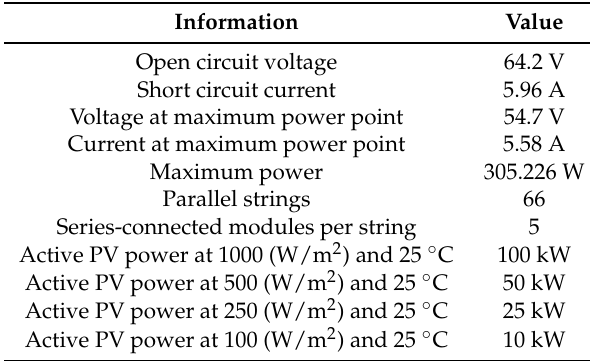
Table 2. Specifications of SunPower SPR-305E-WHT-D (SunPower, San Jose, CA, USA) PV module.